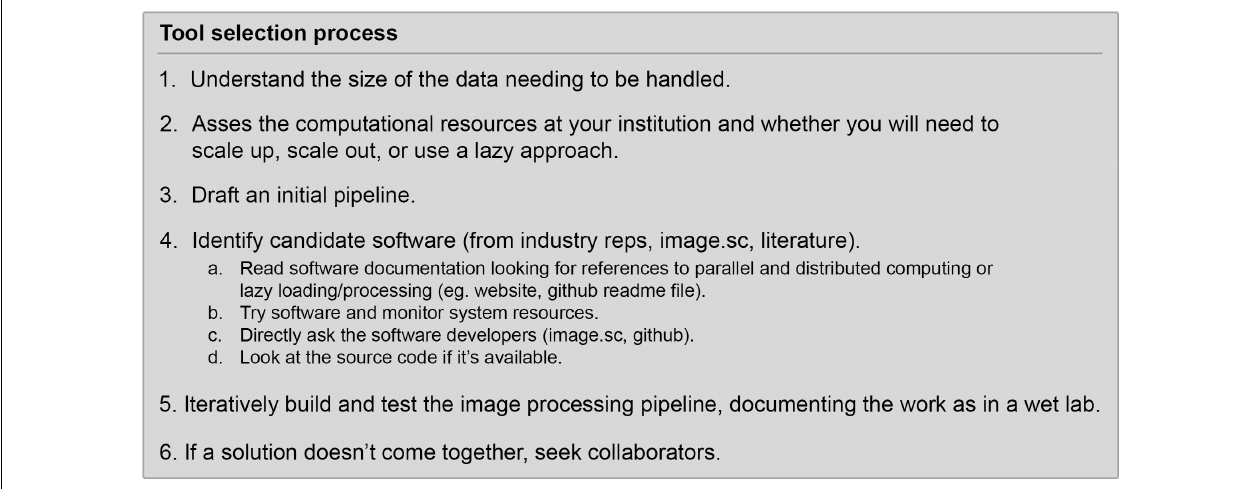
Frontiers in Cell and Developmental Biology |